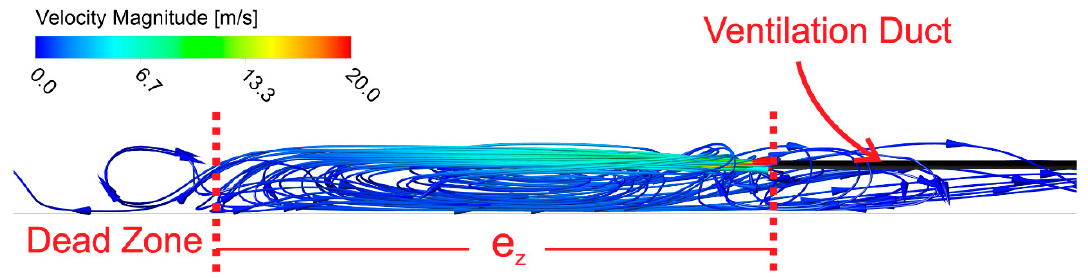
Figure 9. Counter vortices formation in the dead zone.